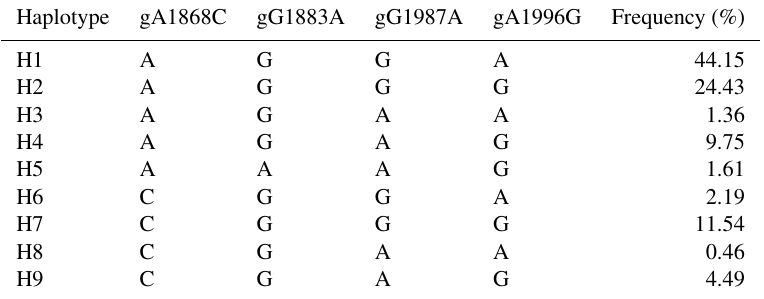
Table 4. Haplotypes of four mutations in the AMH exon 2.